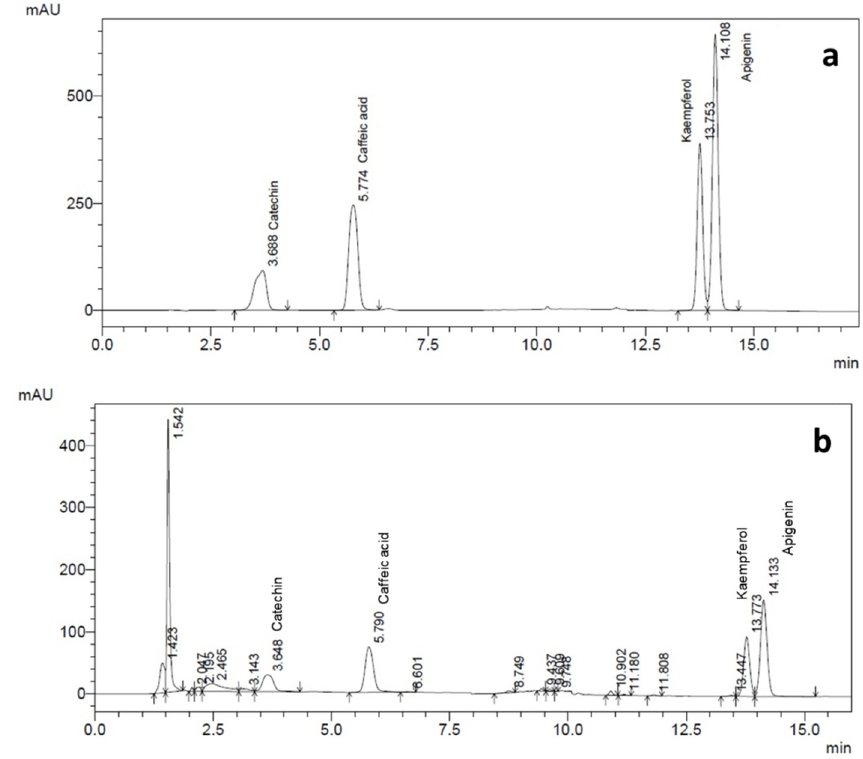
Figure 1. HPLC chromatograms: ( a ) Chromatogram showing the retention time of standard com- pounds, and ( b ) chromatogram showing the retention time of tested polyphenols.